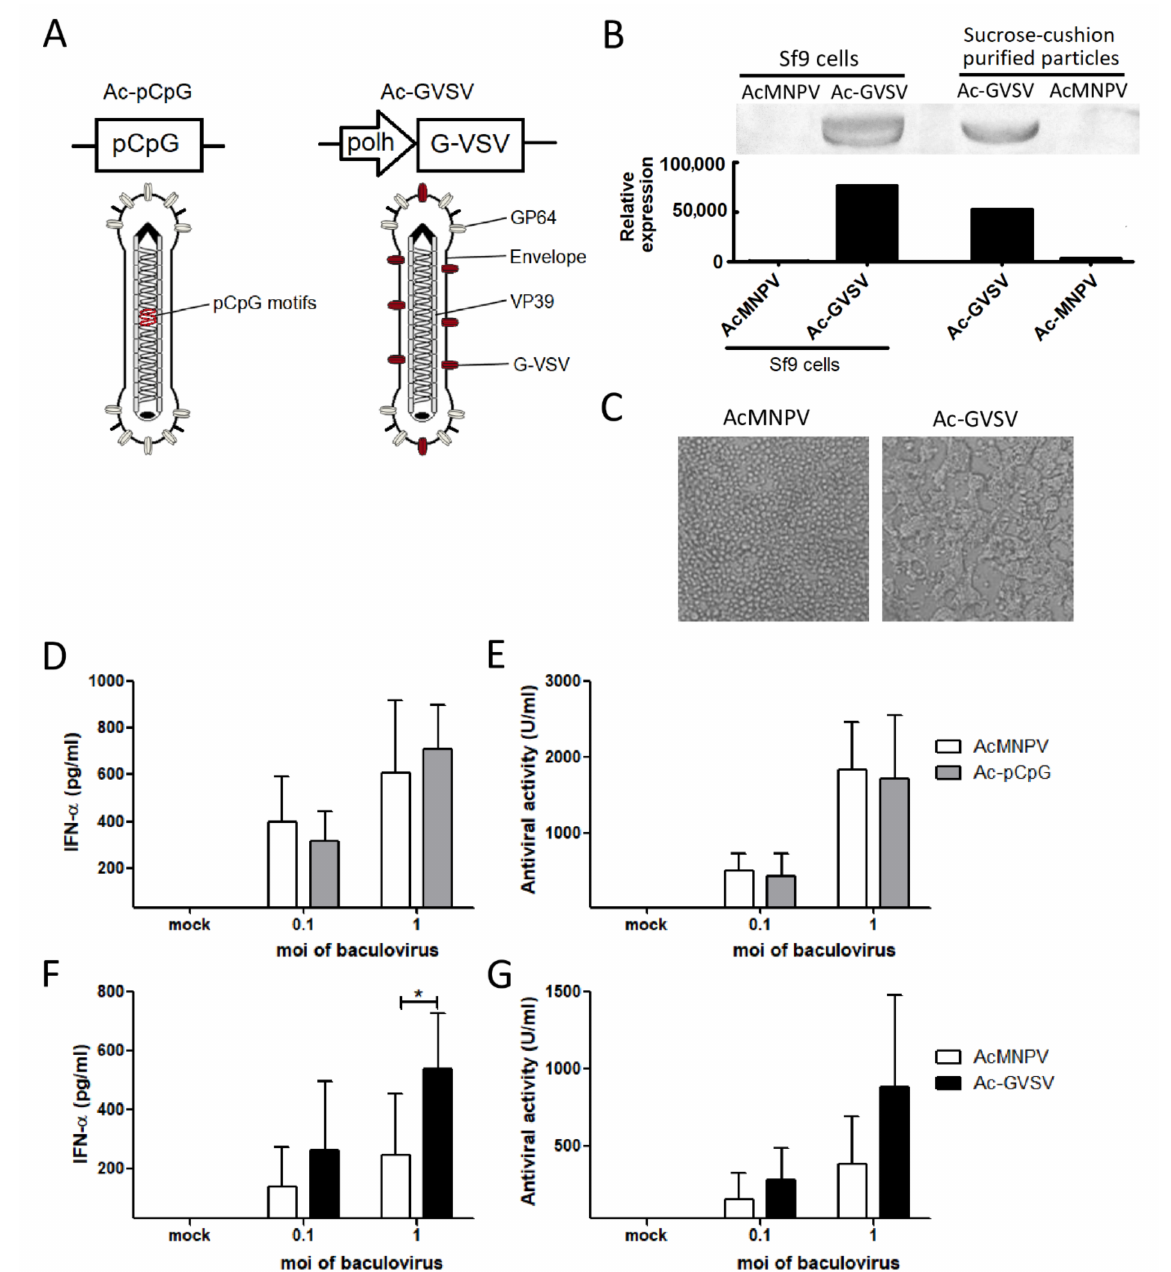
Figure 4. The pseudotyping of AcMNPV with G-VSV, but not the enrichment with immunostimulatory CpG ODNs, improves the induction of IFN- α . ( A ) Schematic representation of the recombinant baculoviruses Ac-GVSV and Ac-pCpG. The main components are pointed out. ( B ) Western blots of sucrose-cushion purified Ac-GVSV particles and AcMNPV- and Ac-GVSV-infected Sf9 cells were revealed with anti-GVSV mAb to evidence the presence of the glycoprotein and the density reading of each band was represented in the graph below. ( C ) Sf9 cells were infected with AcMNPV or Ac-GVSV at 27 ◦ C and pH 6.2 for 7 days and observed by optical microscopy (200 × ). ( D – G ) PBMCs from three piglets were either mock-infected or infected with AcMNPV (3.37 × 10 8 ± 1.2 × 10 7 PFU/mL), Ac-pCpG (2.69 × 10 8 ± 5.1 × 10 7 PFU/mL), or Ac-GVSV (2.44 × 10 8 ± 2.55 × 10 7 PFU/mL) at the indicated moi for 16 h to subsequently collect the supernatants. ( D , F ) IFN- α levels in supernatants were quantified by ELISA. ( E , G ) The antiviral activity against VSV serotype Indiana of the supernatants was assayed in MDBK cells. Standard porcine IFN- α was used for the quantification of antiviral activity units (1 U corresponds to 2.16 pg IFN- α ; IC 50 ~ 7.22 U/mL). The results are from one experiment that is representative of at least three independent experiments. Paired sample t -test was performed in all the experiments to identify differences between viruses. * p <